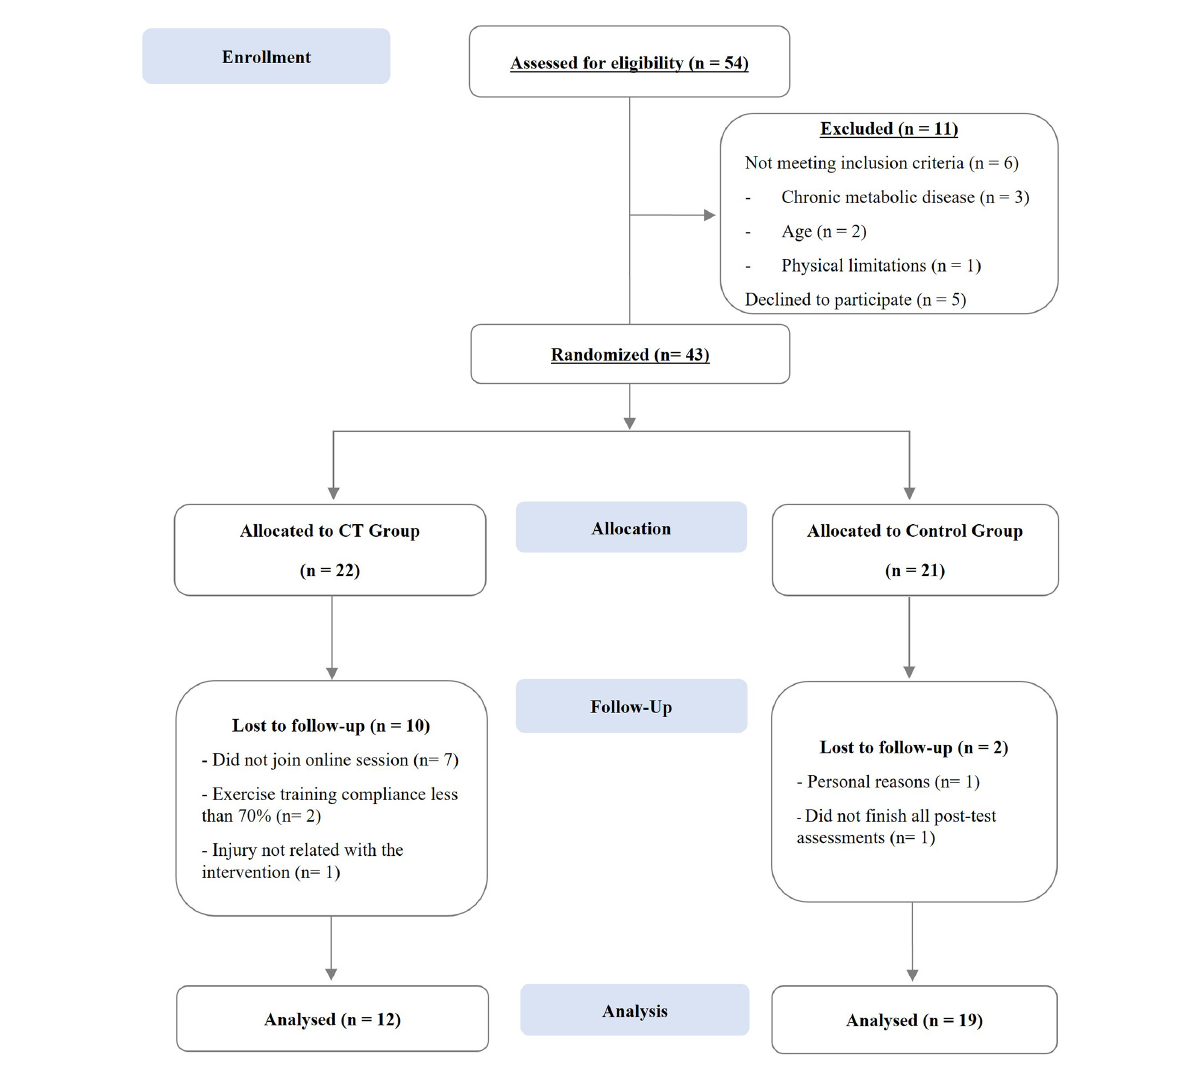
FIGURE2 CONSORT diagram of study participants through each stage of the